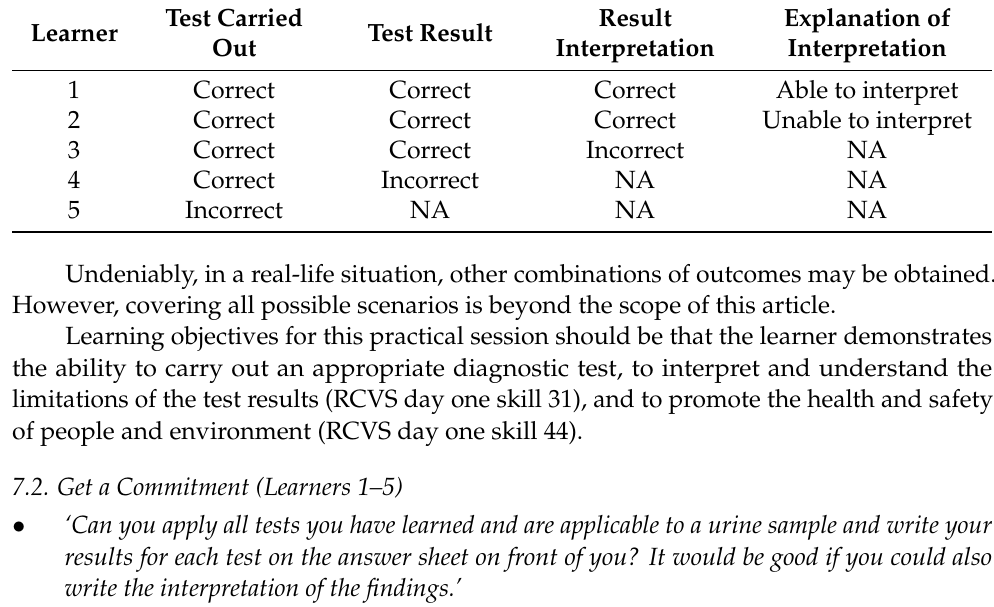
Table 2. Urine assessment results of learners and their